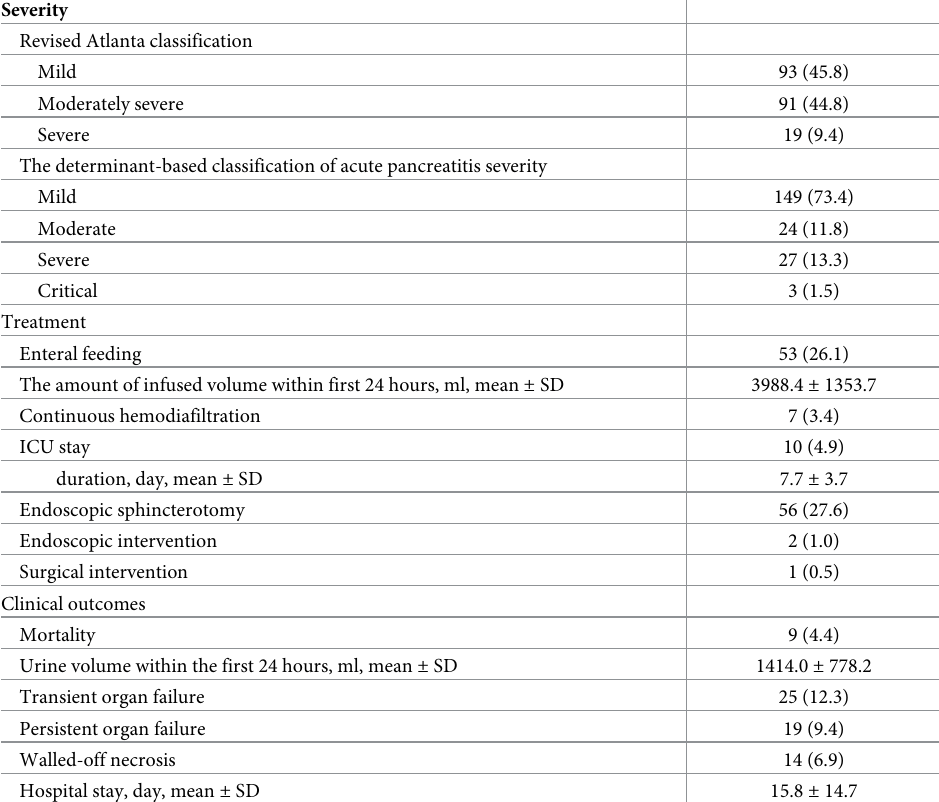
Table 2. Severity, treatment and clinical outcomes (n =